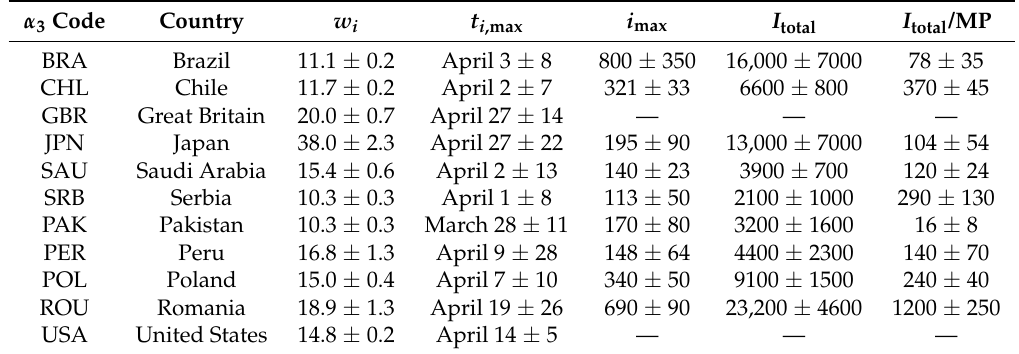
Table A1. GM parameters w i , t i ,max , and i max for those countries, for which sufficient data about infections, but insufficient data about fatalities is available to us, as of April 2. The coefficient i max we could not extract from the existing data with an error less than 100%. Parameters w i , t i ,max , i max were used to create Figure